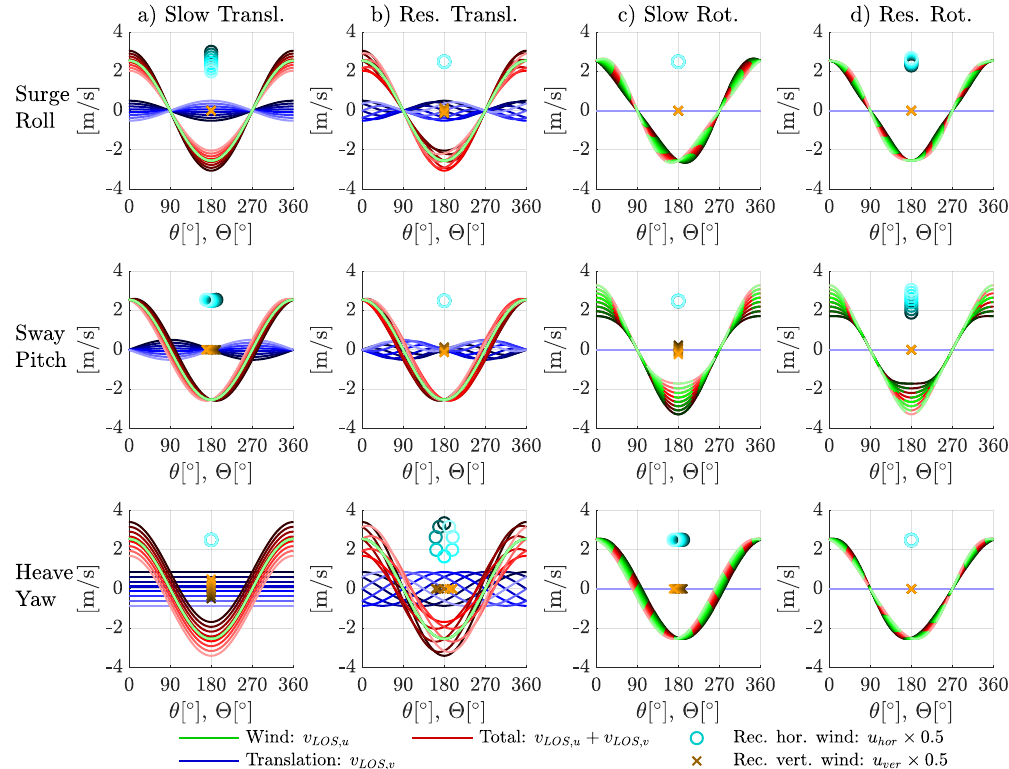
Figure 2. Overview of the influence of motion on line-of-sight estimates and reconstructed wind vectors of a velocity–azimuth display (VAD) scanning floating lidar system. Shown are examples of translational motion with ˆ v = 1ms − 1 amplitude oscillating with frequency ( a ) f v (cid:28) 1Hz and ( b ) f v = 1Hz, and the rotational motion of 10.5 ◦ peak angle oscillating with ( c ) f v (cid:28) 1Hz and ( d ) f v = 1Hz, where 1Hz is the rotation frequency of the lidar prism. Green lines (dashed in c , d ) are the radial velocity components of constant horizontal wind blowing in θ = 0 ◦ direction with a magnitude of U = 5ms − 1 as a function of the lidar azimuth angle θ . Blue lines are the influence of translational motion. Red lines are the total line-of-sight velocities. Color shades represent different phases of the oscillatory motion. Circle and cross markers represent the reconstructed wind vectors after conventional VAD processing, where the position on the y -axis is the magnitude and the position on the x -axis is the wind direction Θ . More information in Section